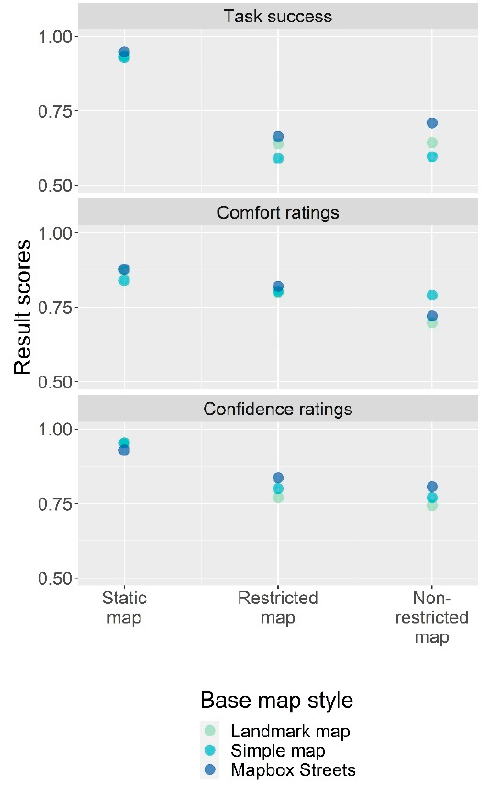
Figure 13. Task success, comfort, and confidence ratings of interactivity variant by base map styles.